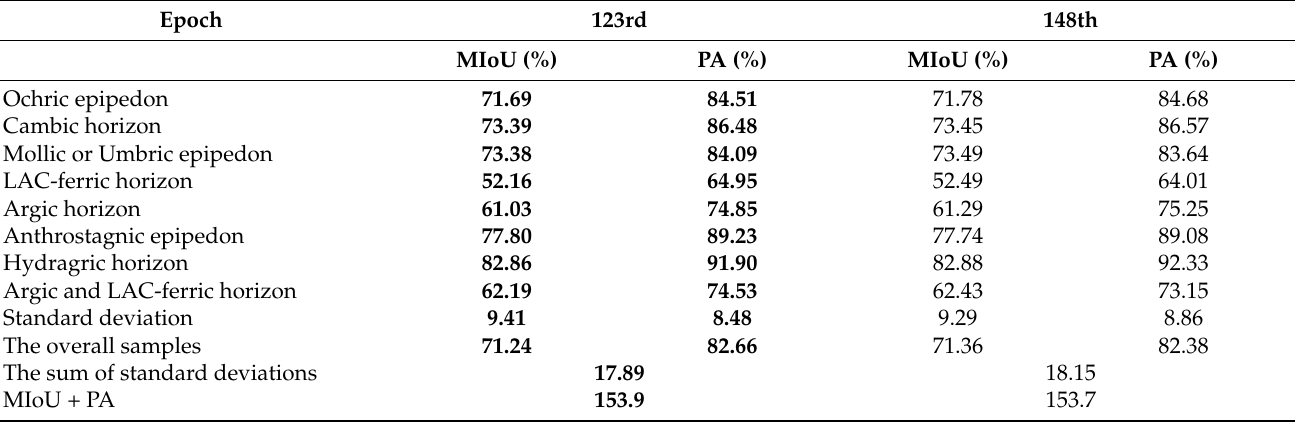
Table 4. Different metrics of the models generated in the 123rd and 148th epochs. The standard deviation indicates the standard deviation of the corresponding indicator for all diagnostic horizons.